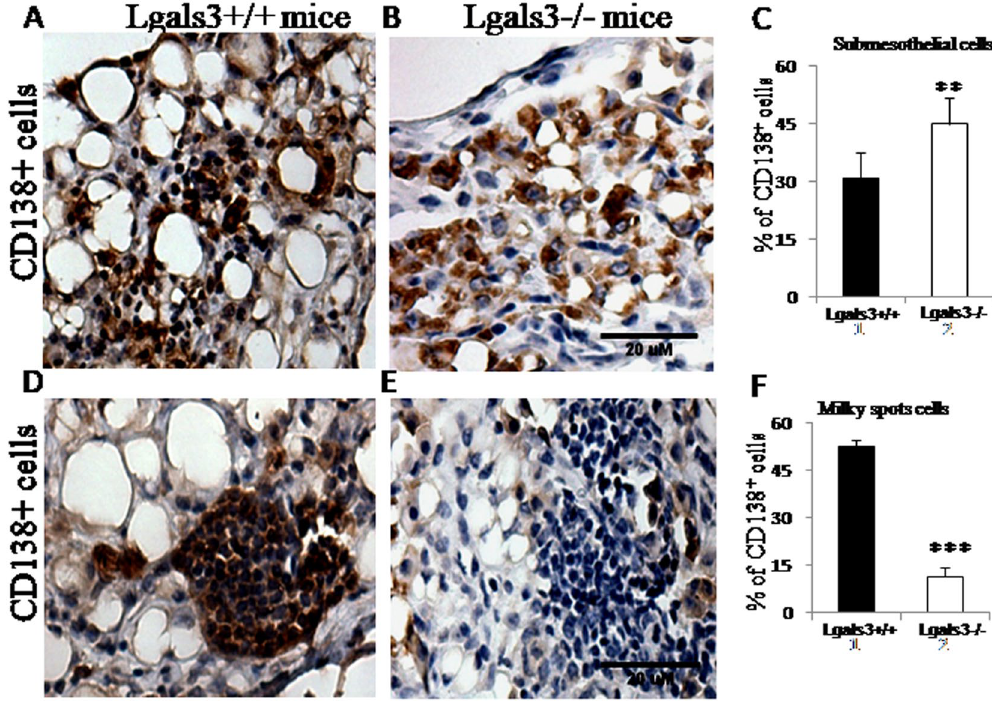
Figure 6. Immunohistochemistry to detect B lymphocyte and plasma cell niches in mesentery of pristane- induced mice. CD138 + cells localized in non-lymphoid submesothelial regions of Lgals3 + - + ( A ) and Lgals3 − / − mice ( B ). These cells were quantified and plotted in graph bars ( C ). CD138 + cells observed in milky spots of Lgals3 + / + ( D ) and Lgals3 − / − mice ( E ). Bar graphs indicate the percentage of CD138 + cells in milky spots ( F ). Black bars represent Lgals3 + / + mice whereas white bars represent Lgals3 − / − mice. Magnification: A-D (500 × ). ( ** ) indicates p < 0.01. ( *** ) indicates p <